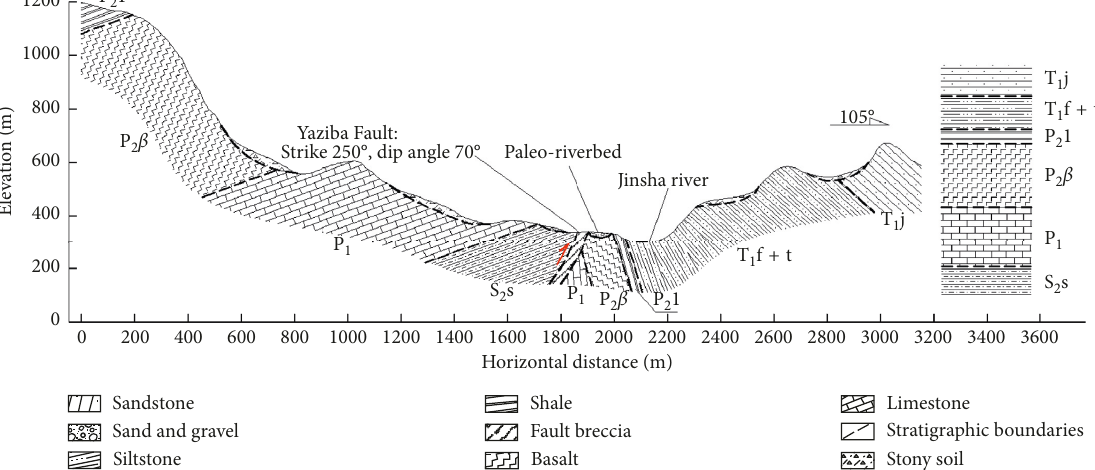
Figure 6: Cross section A-A . See Figure 4 for its location. S 2 s: Silurian Shimenkan formation, P 1 : lower Permian strata, P 2 β : Permian Emeishan basalt, P 2 1: Permian Leping formation, T 1 f+t: Triassic Feixianguan and Tongjiezi formations, and T 1 j: Triassic Jialingjiang ′